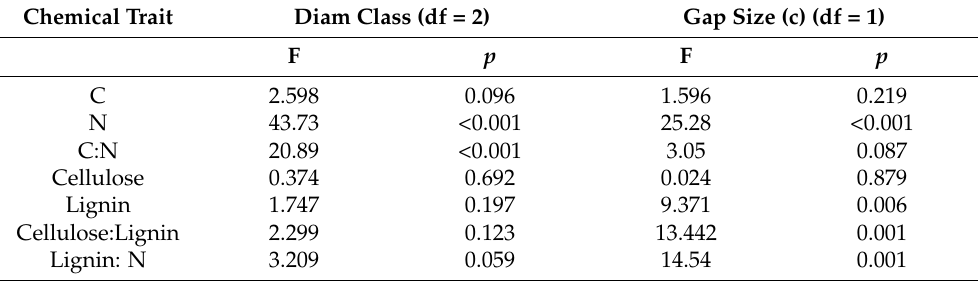
Table 2. F and p values of ANCOVA (General Linear Model) for the effects of diameter classes on chemical fine root traits. Gap size was used as a covariate. Interactions were not significant and therefore excluded from the model. Boldface p values are significant at a probability level of p < 0.05. Chemical Trait Diam Class (df = 2) Gap Size (c) (df = 1) F p F p C 43.73 <0.001 25.28 <0.001 20.89